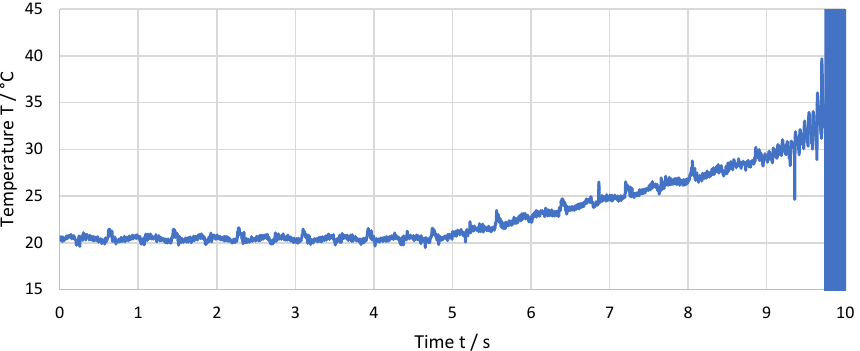
Figure 7. Measured temperature over the last 10 s before the destruction of the thermocouple for a feed of f = 36 µm. Figure 8 shows an enlarged view of the last 2 seconds before the destruction of the thermocouple. The cutting speed of v c = 459 m/min is achieved at an approximately 1000 rpm rotational speed of the spindle. This translates to a cutting frequency of approxi- mately 17 Hz. The temperature peaks are clearly visible for the last 10 cuts. The frequency of the peaks corresponds to the cutting frequency and, therefore, the individual peaks can be related to single cuts. For each cut, the temperature rises fast to a temperature maxi- mum and then drops back at a lower change rate almost to the temperature before the cut.